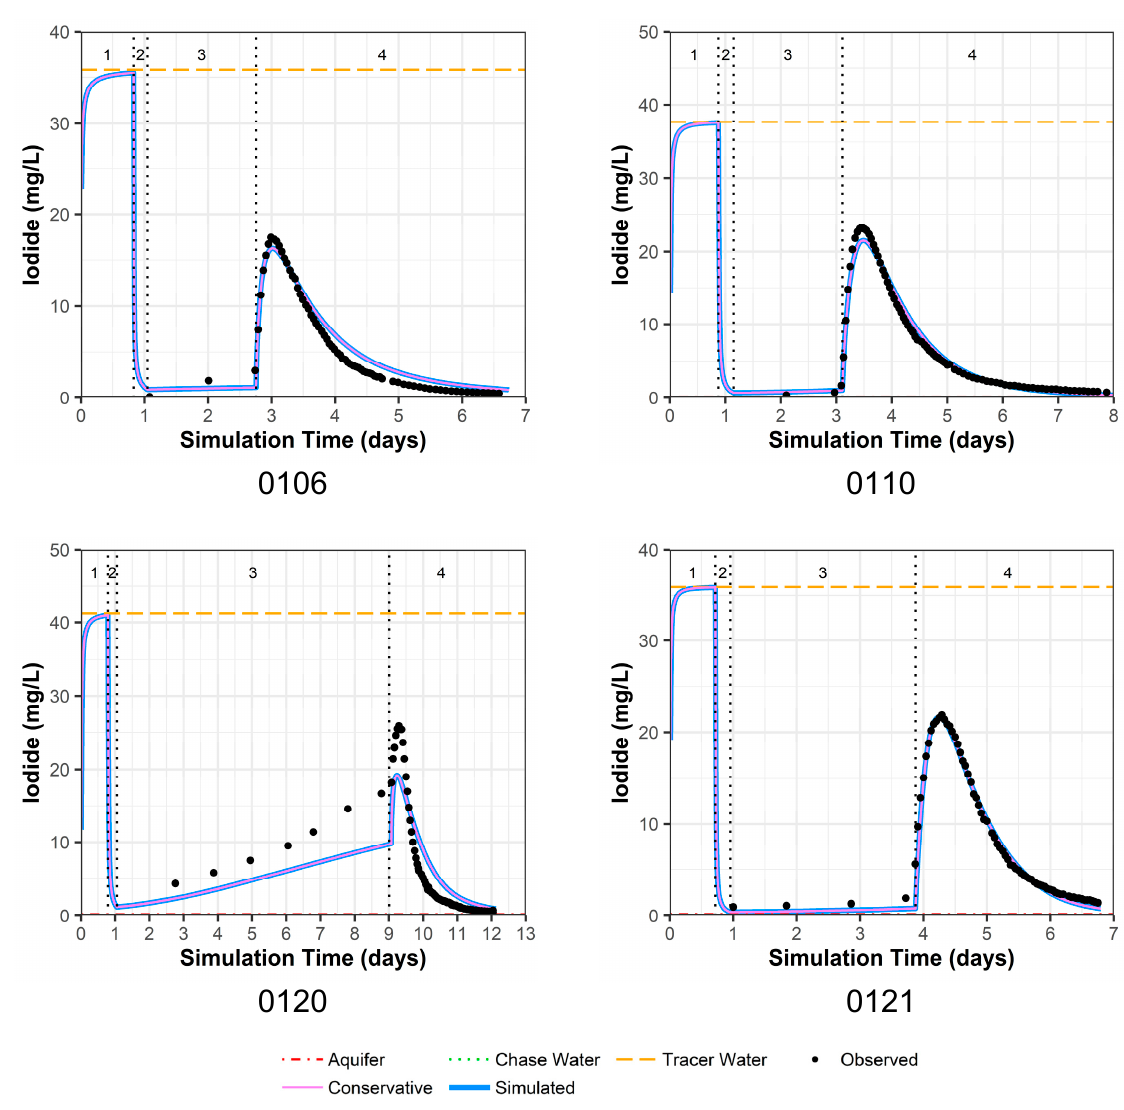
Figure 4. Model fit for iodide in all four PPT wells with a multilayer approach. Phases are: (1) traced river water injection, (2) untraced river water injection (chase), (3) drift phase, and (4) pumping phase.